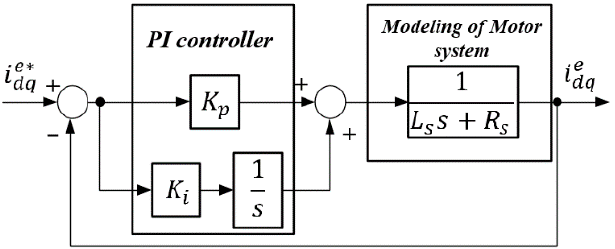
Figure 13. Block diagram of the PI controller and electrical model of the motor system.